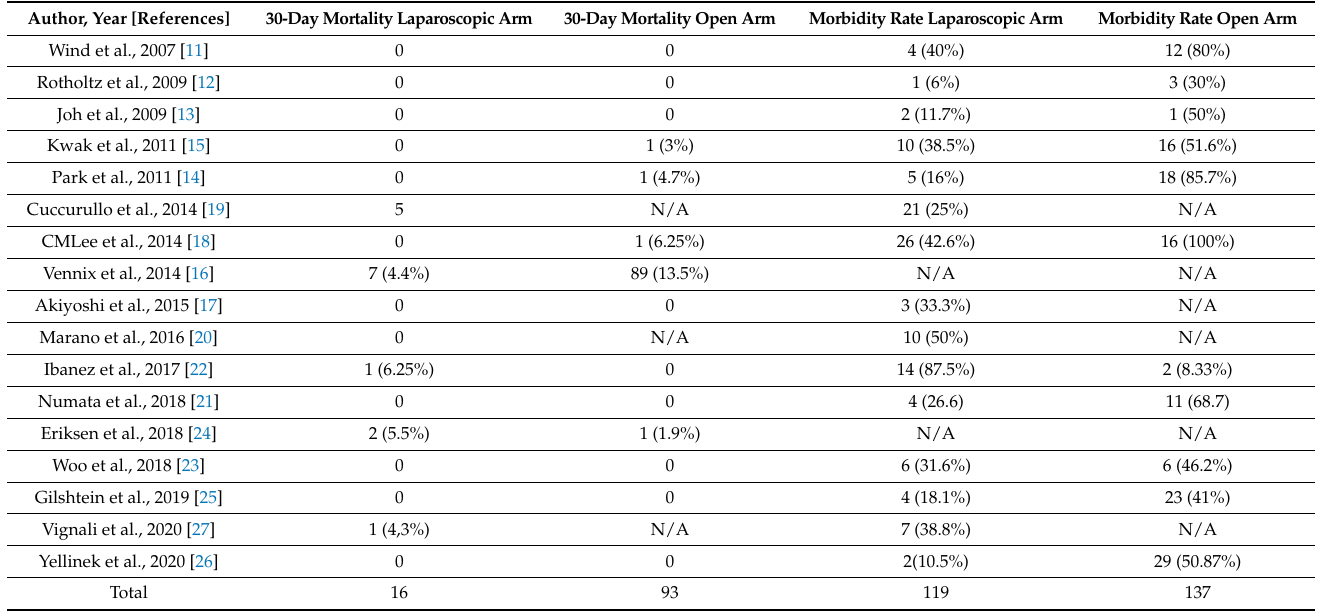
Table 2. Primary